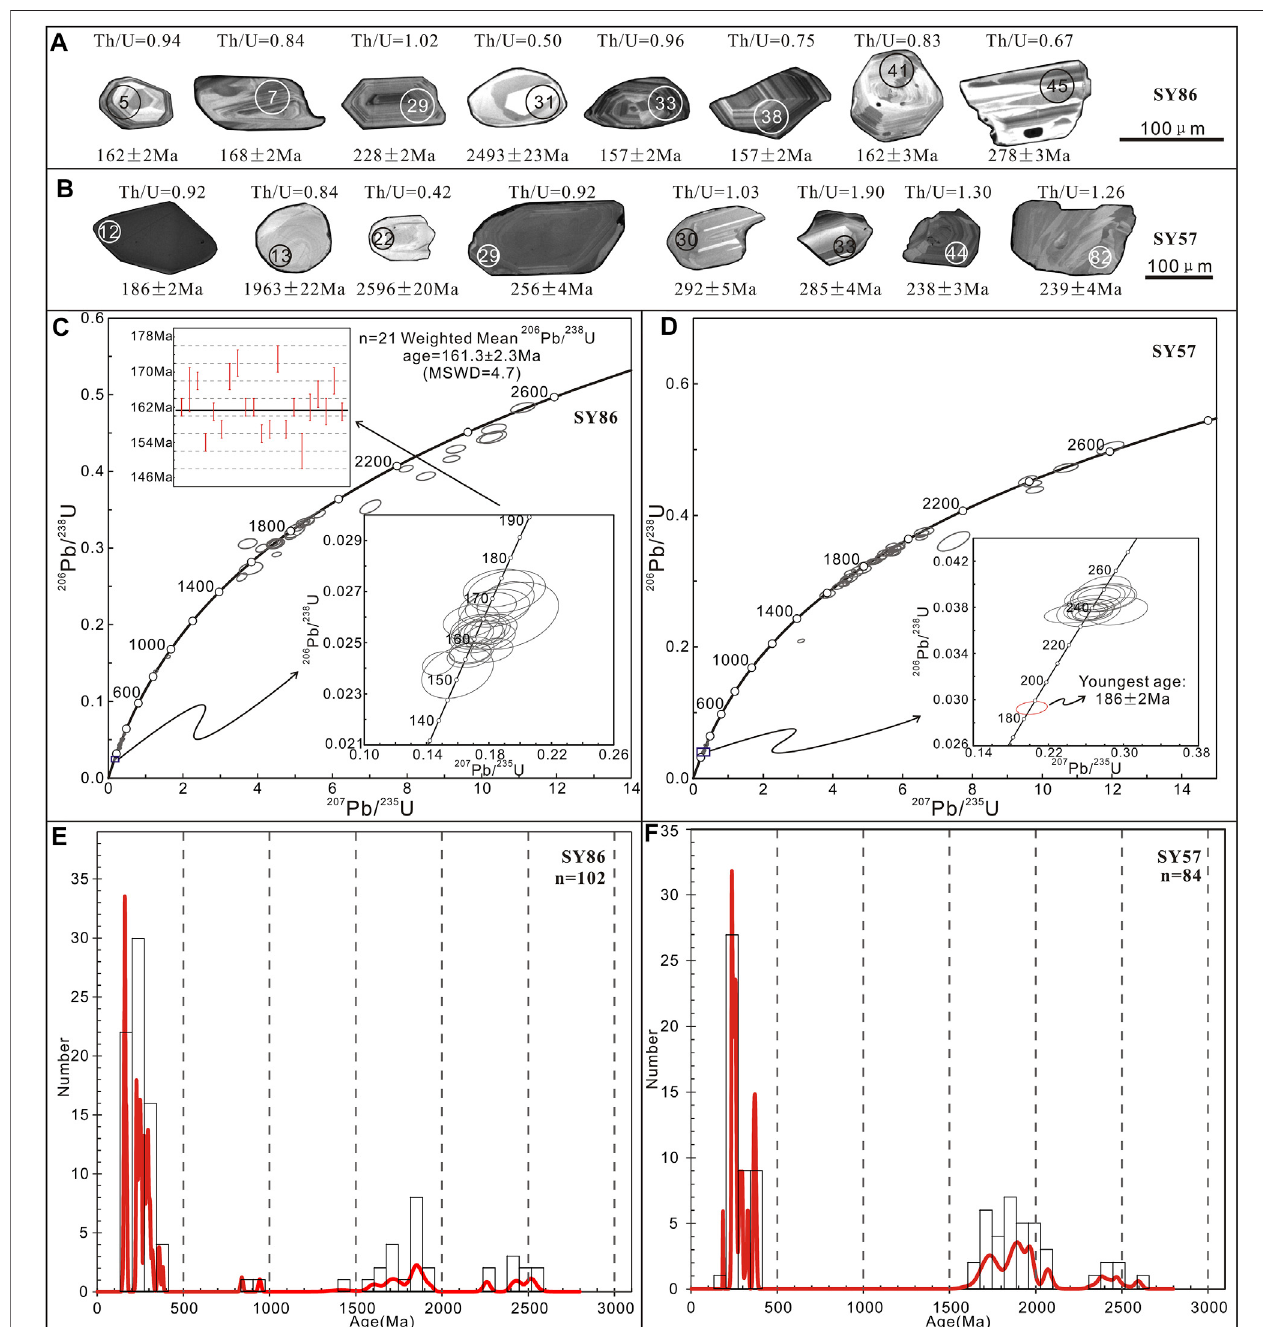
FIGURE 12 | Representative cathodoluminescence (CL) images of zircons and LA-ICP-MS U – Pb zircons dating results for samples SY86 and SY57. (A,B) CL images of zircons for samples SY86 and SY57, respectively. (C,D) Weighted mean calculations and concordia diagrams of zircon ages for samples SY86 and SY57, respectively. (E,F) Histograms of zircon ages for two samples (SY86 and SY57). See text for more details.